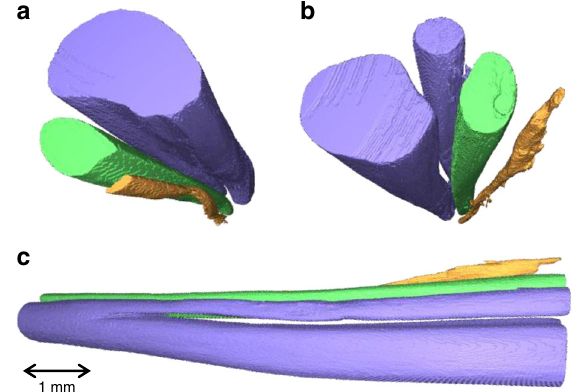
Fig. 3 Example of microCT segmentation of rat sciatic nerve. The segmented tibial (purple large), peroneal (green), sural (purple small, branching off tibial), and post-cutaneous (orange) fascicles can be seen from the a proximal, b distal, and c from proximal to distal (left to right) orientations.